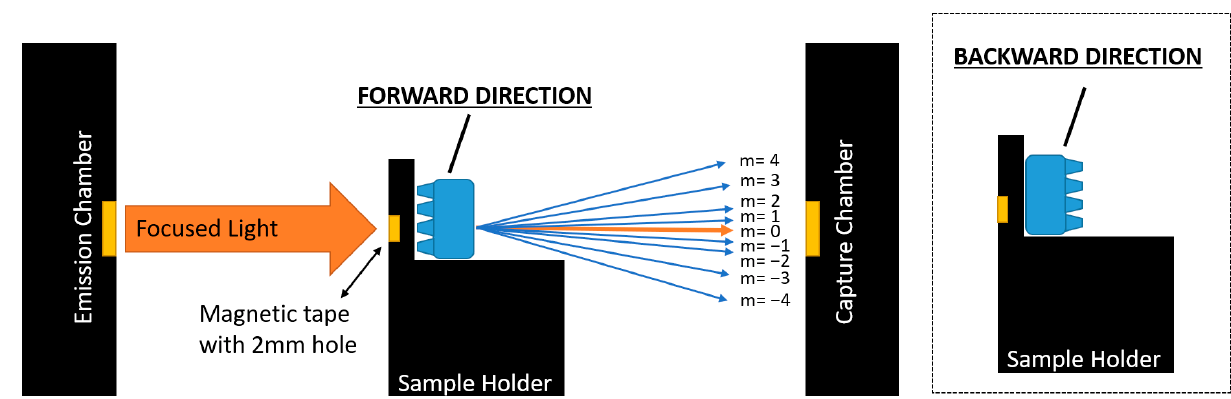
Figure 2. Schematic showing the testing setup in the forward direction with the 2 mm magnetic tape focusing hole. The angular dispersion of the ALT grating with the sample oriented for “forward” direction data collection is illustrated. The sample mounting for testing in the backward direction is also shown.